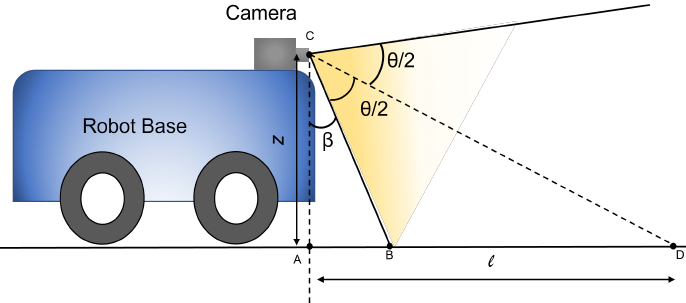
Figure 3. The side-view of the robot with the field-of-view of the camera.